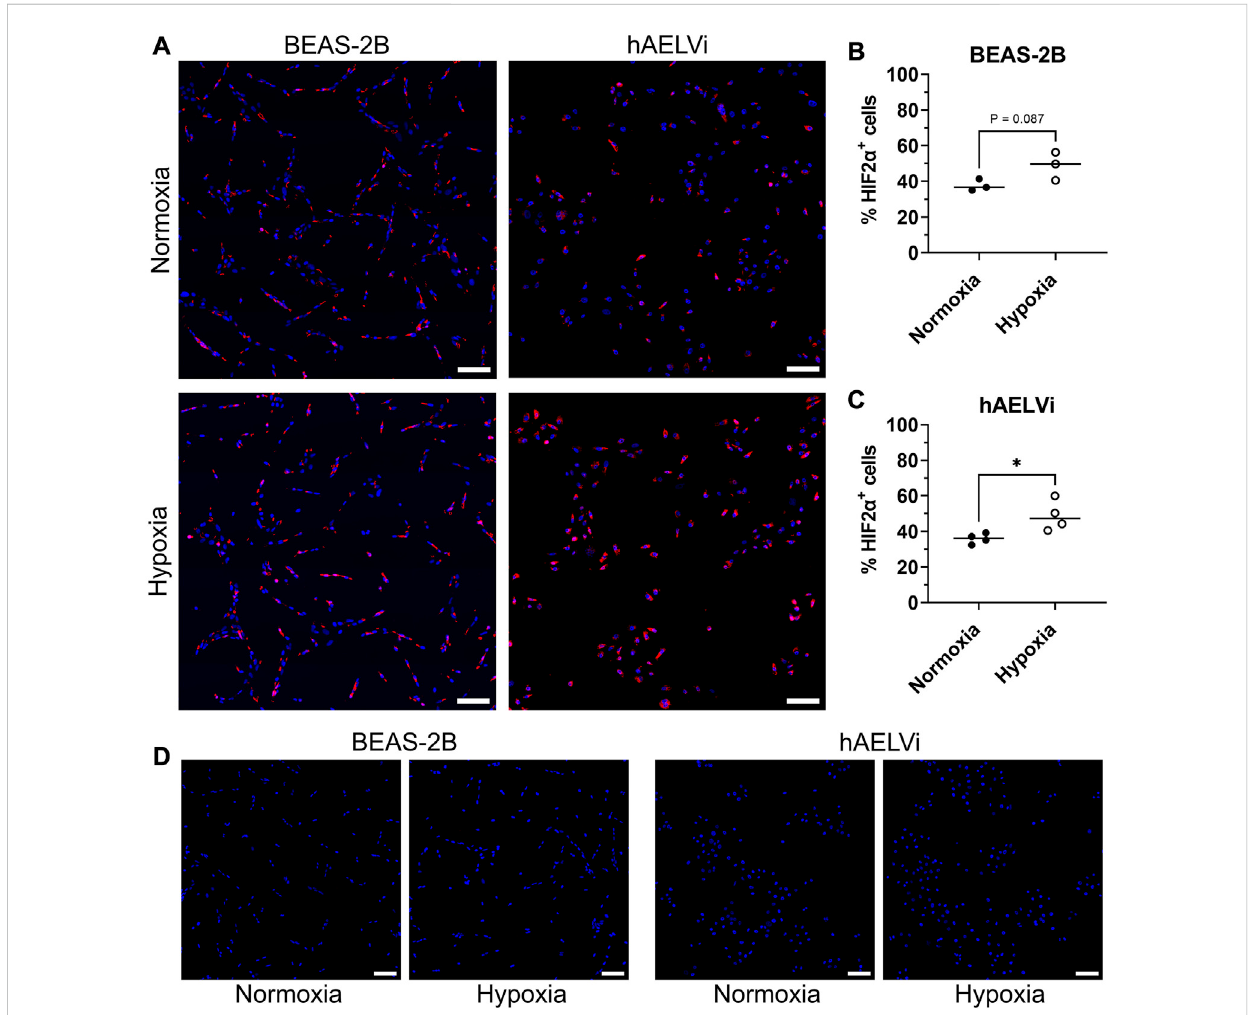
FIGURE 2 Immuno fl uorescence staining of HIF2 α in BEAS-2B and hAELVi exposed to normoxia compared to hypoxia (A) . DAPI (blue) and HIF2 α (red). Scale bar = 100 µm. Quantitative analysis of HIF2 α + cells in BEAS-2B (B) and in hAELVi (C) . Control staining without the anti-HIF2 α primary antibody (D) . DAPI (blue) and HIF2 α (red). Scale bar = 100